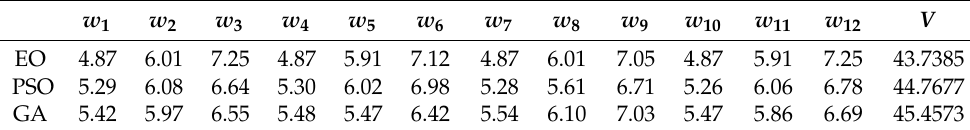
Table 11. Allocated tasks for the AUVs and the value of the goal function in the large-scale system under w total = 72 kg. w